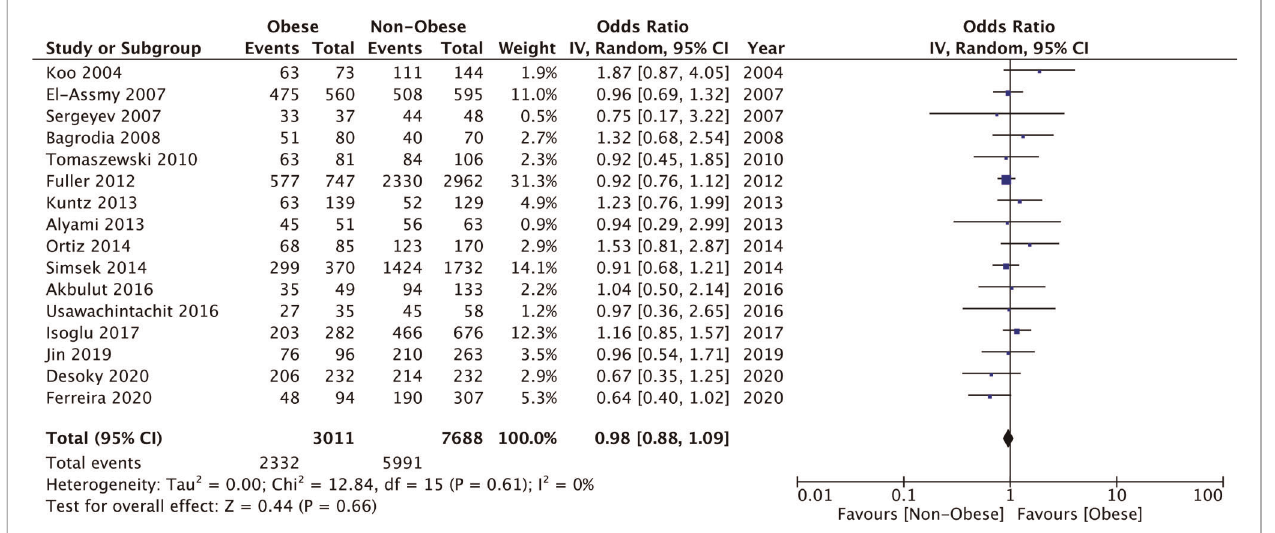
FIGURE 3 | Meta-analysis of stone-free rates between obese vs non-obese patients.